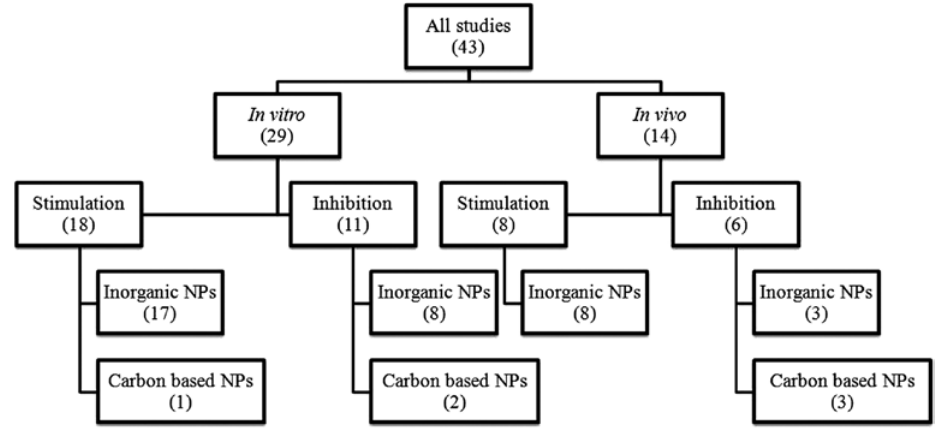
Figure 3: Distribution of cited articles according to the type of studies, observed effect and NPs type